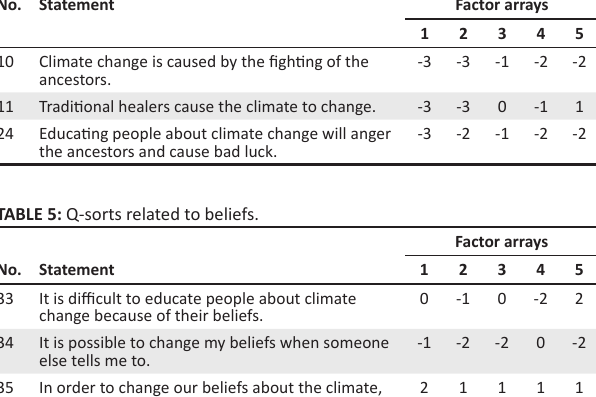
TABLE 4: Q-sorts linked to ancestral beliefs and traditional healers. No. Statement Factor arrays